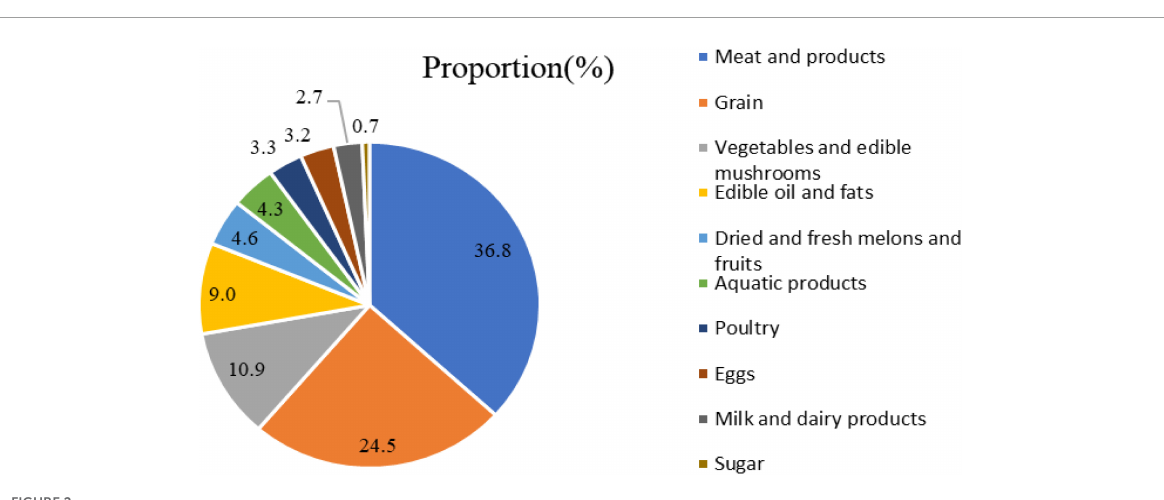
FIGURE2 Rural residents’ food consumption expenditure structure in 2020, unit: %.